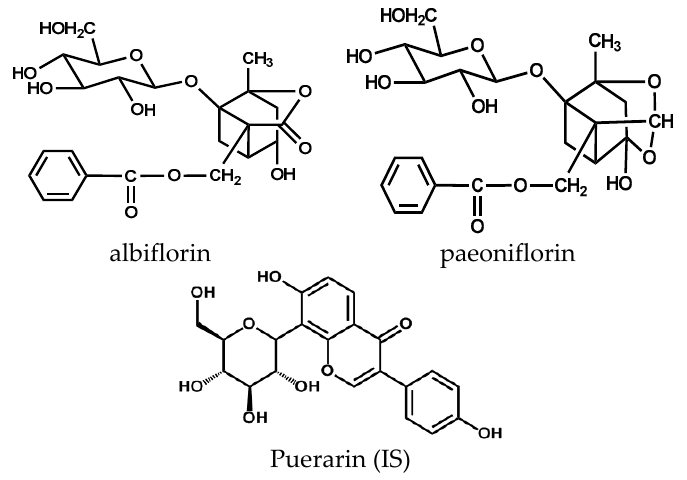
Figure 1. The chemical structures of albiflorin, paeoniflorin and puerarin (IS).